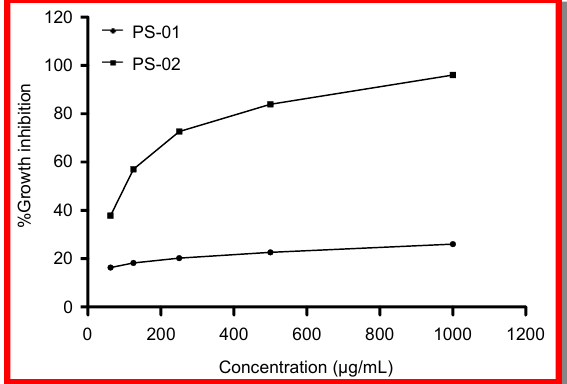
Figure 1: Graphical representation of cytotoxic effect of drugs on MCF-7 cell line